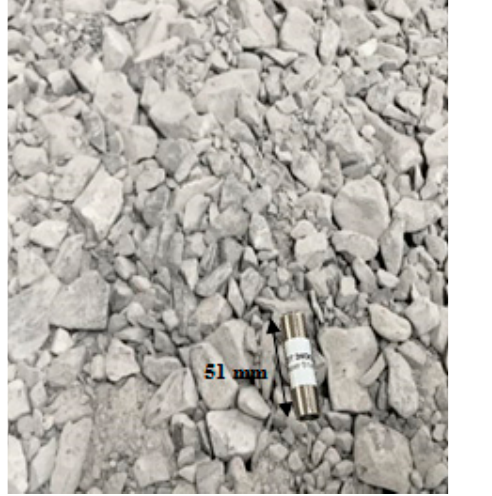
Figure 1. Photos of ( a ) WR1 and ( b ) WR2.